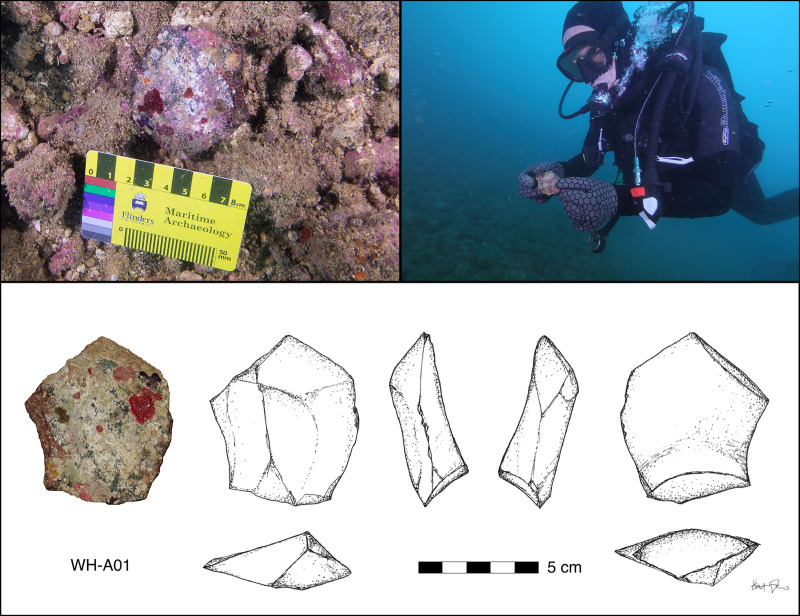
A single artefact was recovered from Flying Foam Passage (WH-A01) where additional material may be present rendering the area a high priority target for future investigations.Inspection below marine encrustations reveals a clear striking platform, a bulb of percussion and dorsal ridges. (Photographs: H. Yoshida; C. Wiseman; Drawing: K. Jerbić).